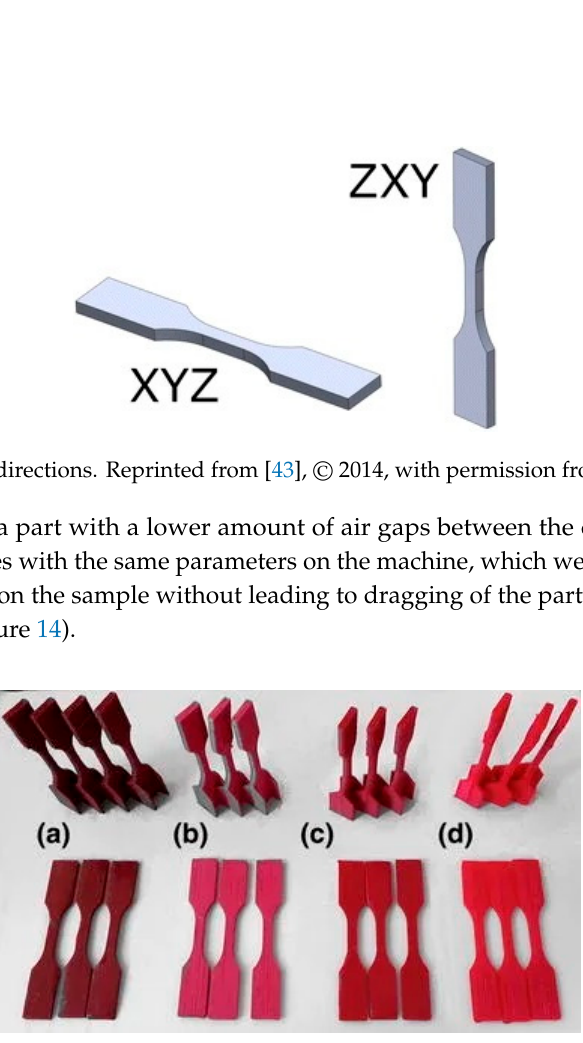
Figure 14. Samples (vertical above, horizontal below): ( a ) ABS and jute fiber, ( b ) ABS and TiO 2 , ( c ) ABS with thermoplastic elastomer (TPE), and ( d ) pure ABS. Reprinted from [43], © 2014, with permission from Springer Nature.